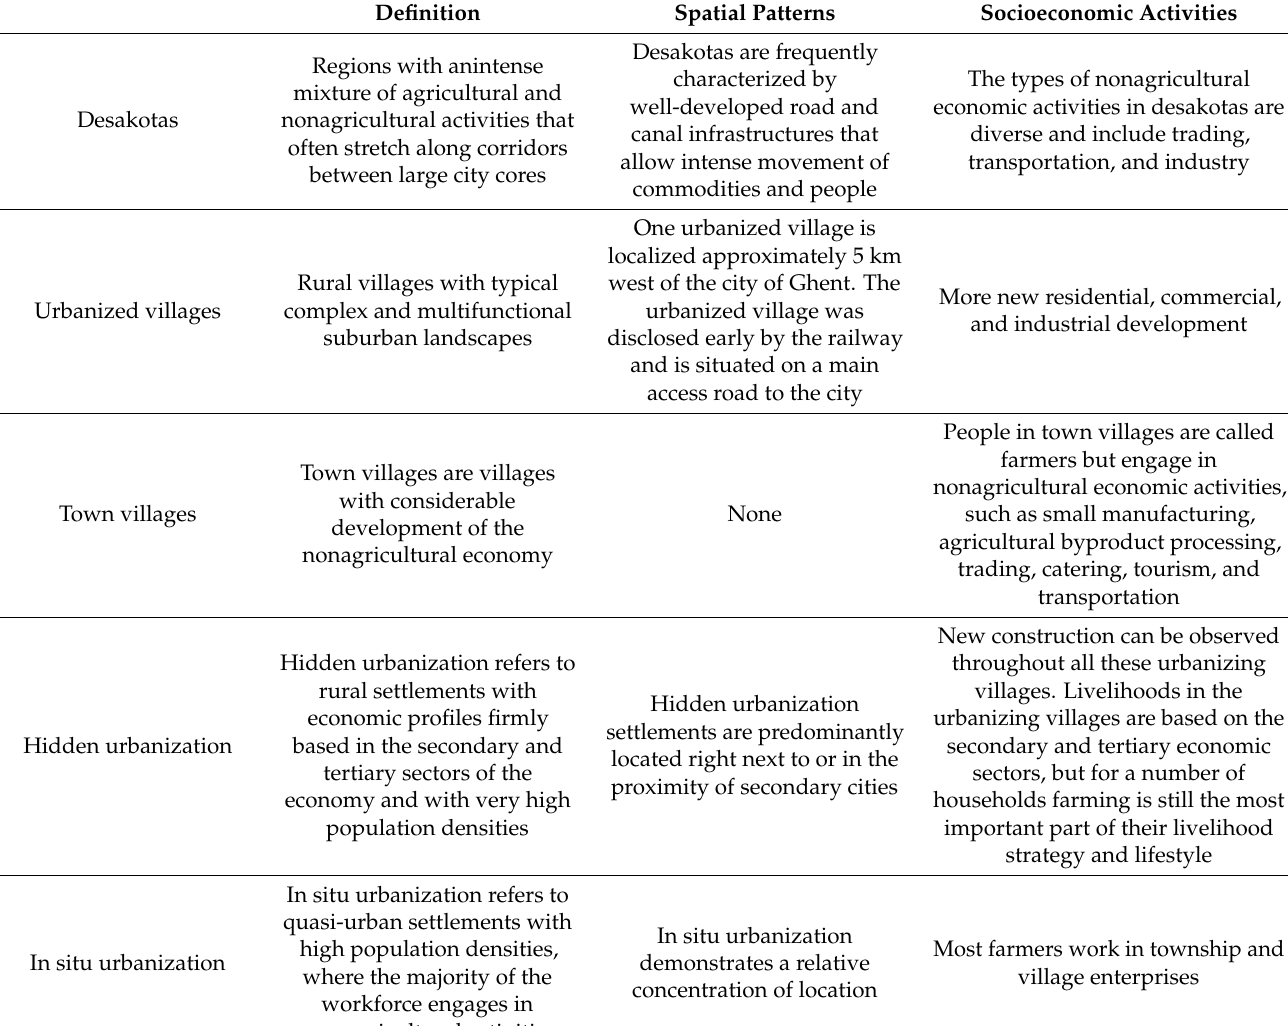
Table 1. Comparison of studies on rural